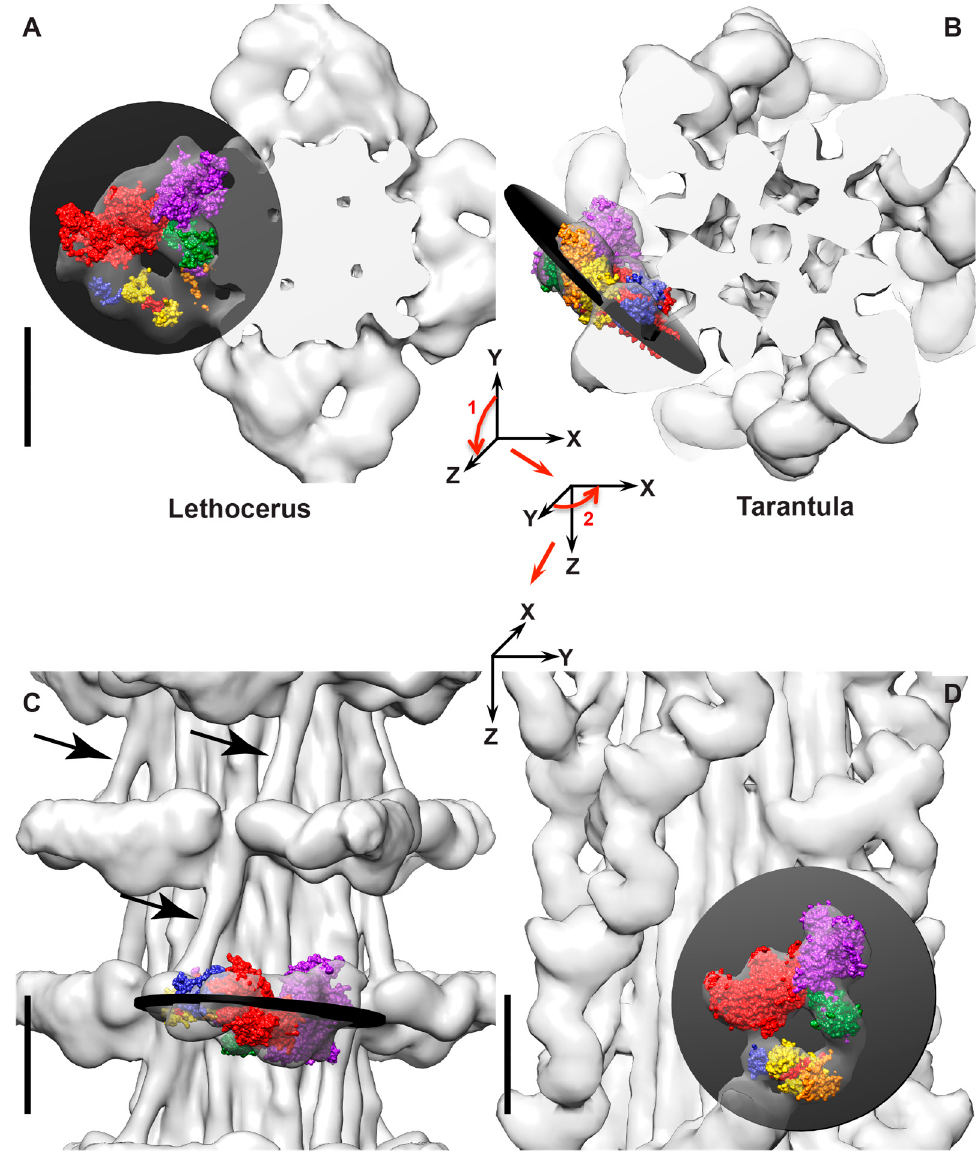
Figure 2. Orientation of the IHM in relaxed thick filaments. Coloring scheme the same as Figure 1F. ( A , C ) Lethocerus thick filament with PDB 1I84 fit into the map [6]. Note how the free head is placed tangentially against the filament backbone and the blocked head extends out into solvent space. ( B , D ) Tarantula thick filament with PDB 3JBH [17]. The IHMs can be approximated as flat planes, indicated by the black disks. Arrows in ( C ) indicate the position of the proximal S2 which is bent towards the left. The IHM of the Lethocerus flight muscle is approximately perpendicular to the filament axis; whereas the tarantula IHM is approximately tangential to the backbone surface. The angle between the plane of the Lethocerus IHM and the plane of the tarantula IHM is 91.6 ◦ . The axes in ( A , B ) indicate the initial M-ward cross-section view and the two 90 ◦ rotations, indicated by the red arrows, needed to transform to the longitudinal view shown in ( C , D ). Scale bars = 10 nm. Adapted from [6].